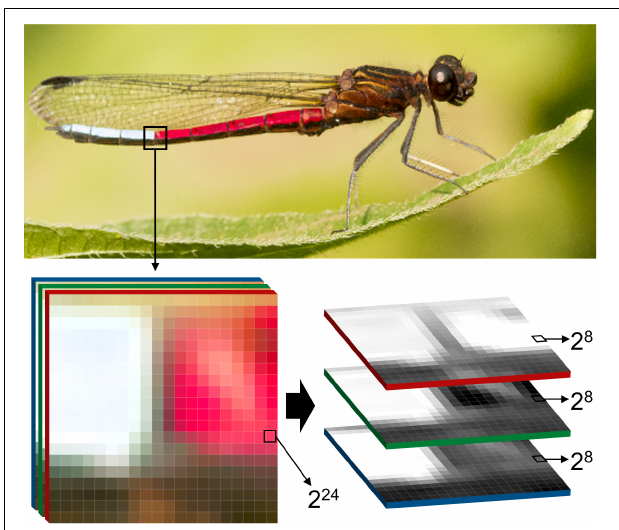
FIGURE 2 | The structure of digital images. Two-dimensional raster images, as produced by most commercially available cameras, are composed of three color channels red, green, blue = RGB), each of which by itself is a grayscale image. The industrial standard for color representation on the pixel level is 24 bit (2 24 = 16 777 216 possible color variations per pixel), which is achieved through additive mixing of each of the 8 bit channels (2 8 + 2 8 + 2 8 ). This enormous range of color intensities among several million pixels is a potentially very high resolution representation of organismal traits, or the organism as a whole. Therefore, digital images are a useful medium for phenomics research, as they offer an inexpensive, memory efficient, and standardizable way to capture, store, and analyze complex phenotypes. The photograph shows a blue-tip jewel damselfly ( Chlorocypha curta ) in Cameroon (Africa, image by ES).